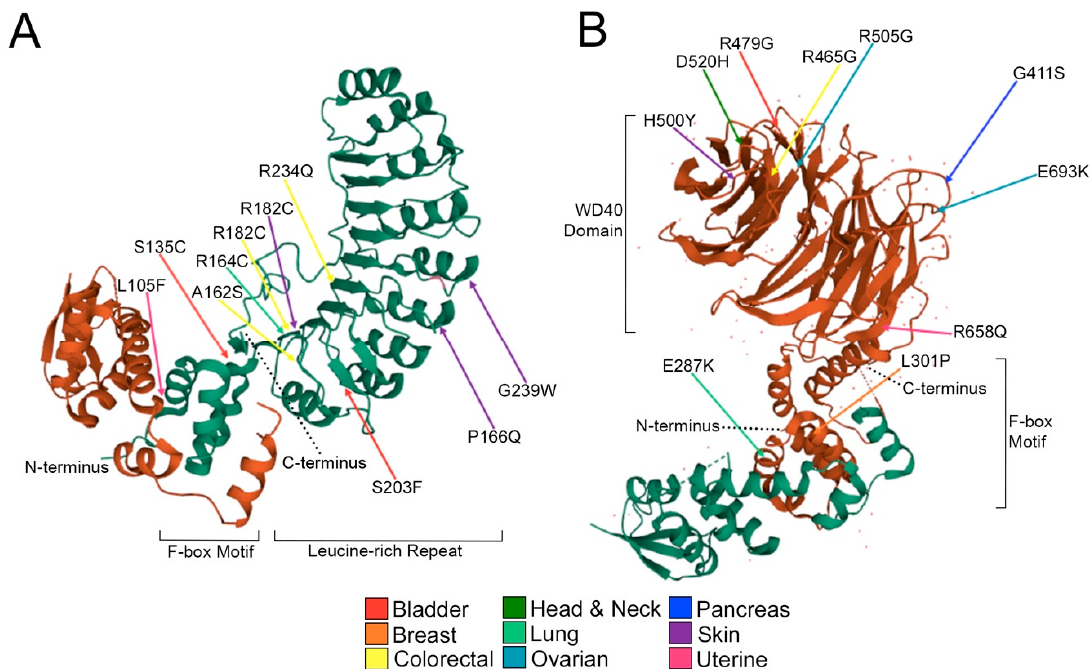
Figure 4. Missense mutations encode potentially detrimental amino acid substitutions in SKP2 and FBXW7. ( A ) Partial crystal structure (missing amino acids 1-88; ribbon model) of the SKP1 (brown)- SKP2 (green) complex presenting predicted damaging alterations. Indicated amino acid substitutions are deemed deleterious, possibly/probably damaging by SIFT and PolyPhen-2 (Table S2) and are predicted to impact protein–protein interactions between SKP1 and SKP2 or SKP2 and its target proteins. Amino acids are denoted by their single letter code, numbers indicate amino acid position in the SKP2 protein. Colored arrows identify cancer type in which the underlying mutation was identified (see key). ( B ) Partial crystal structure (missing amino acids 1-262; ribbon model) of the SKP1 (green)-FBXW7 (brown) complex presents predicted damaging alterations. Indicated alterations are deemed deleterious, possibly/probably damaging by SIFT and PolyPhen-2 and are predicted to impact protein–protein interactions between SKP1 and FBXW7 or FBXW7 and its substrate proteins.